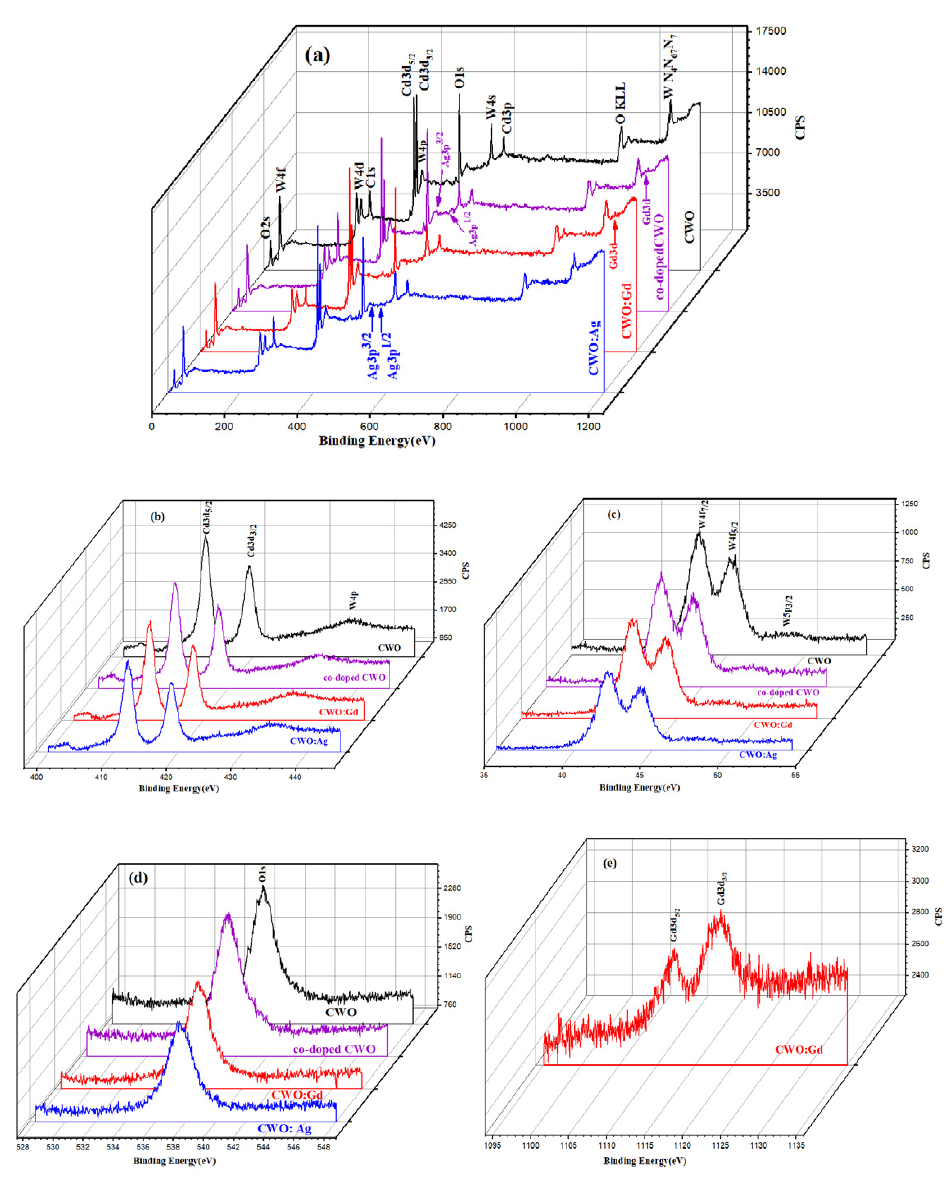
Figure 2: (a) Wide XPS spectra of CWO, CWO: Ag/Gd, and co-doped CWO nanopowders. (b, c, d, e); the narrow scan of the Cd3d, W4f & W5p, O 1s, and Gd3dpeaks, respectively